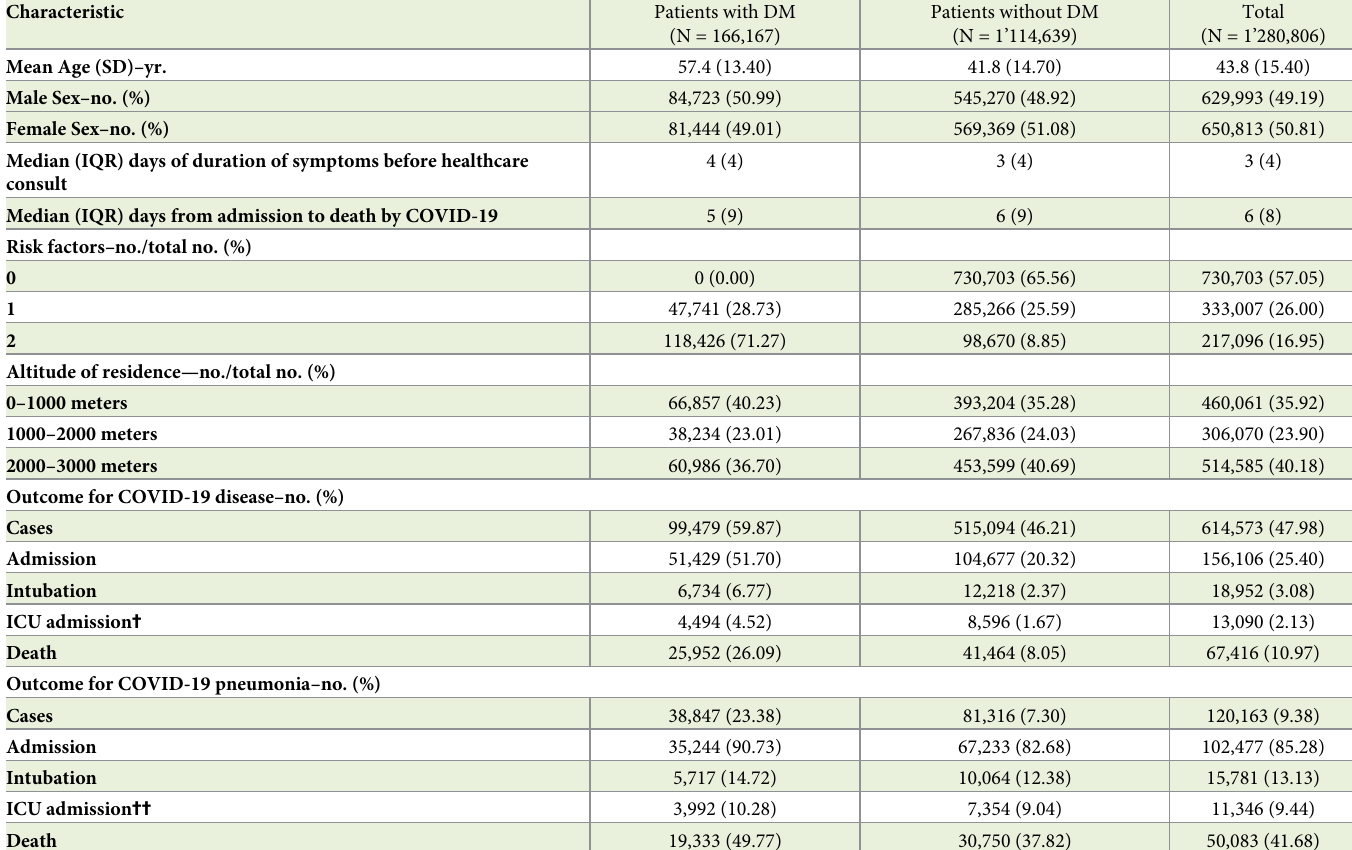
Table 1. Demographic and clinical characteristics of the study population. Characteristic Patients with DM